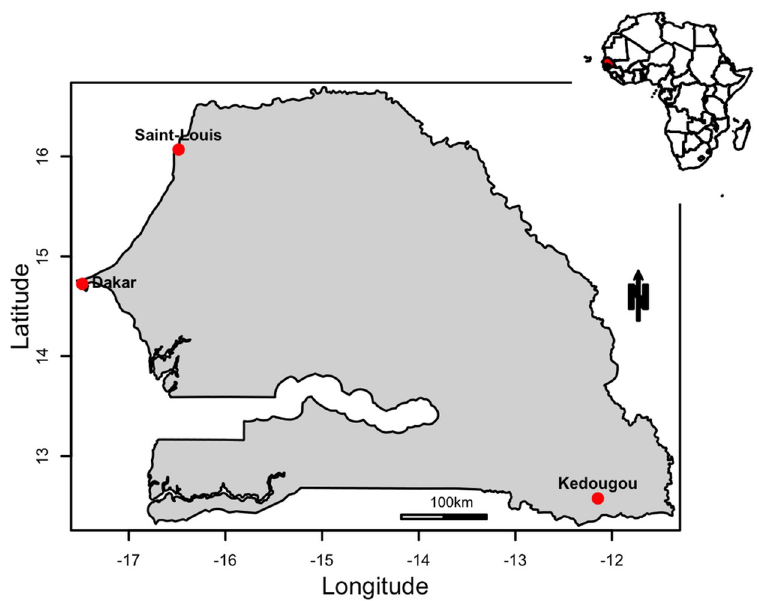
Fig 1. Map showing the three localities where mosquitoes were collected in Senegal for experimental infections with dengue viruses. This map was built using a shapefile from the free domain of the Geographic Information System (http://www.diva-gis.org) with the R software version 3.3.1 and the package maptools.